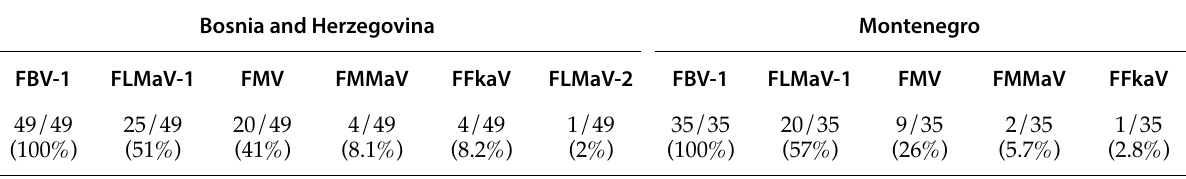
Table 1. Levels of infection for Fig leaf mottle-associated virus 1 (FLMaV-1), Fig leaf mottle-associated virus 2 (FLMaV-2), Fig mild mottle-associated virus (FMMaV), Fig mosaic emaravirus (FMV), Fig fleck-associated virus (FFkaV), Fig latent virus 1 (FLV-1), Fig cryptic virus 1 (FCV-1), Fig badnavirus 1 (FBV-1) from a virus survey of fig trees in Bosnia and Herzegovina and Montenegro during spring,